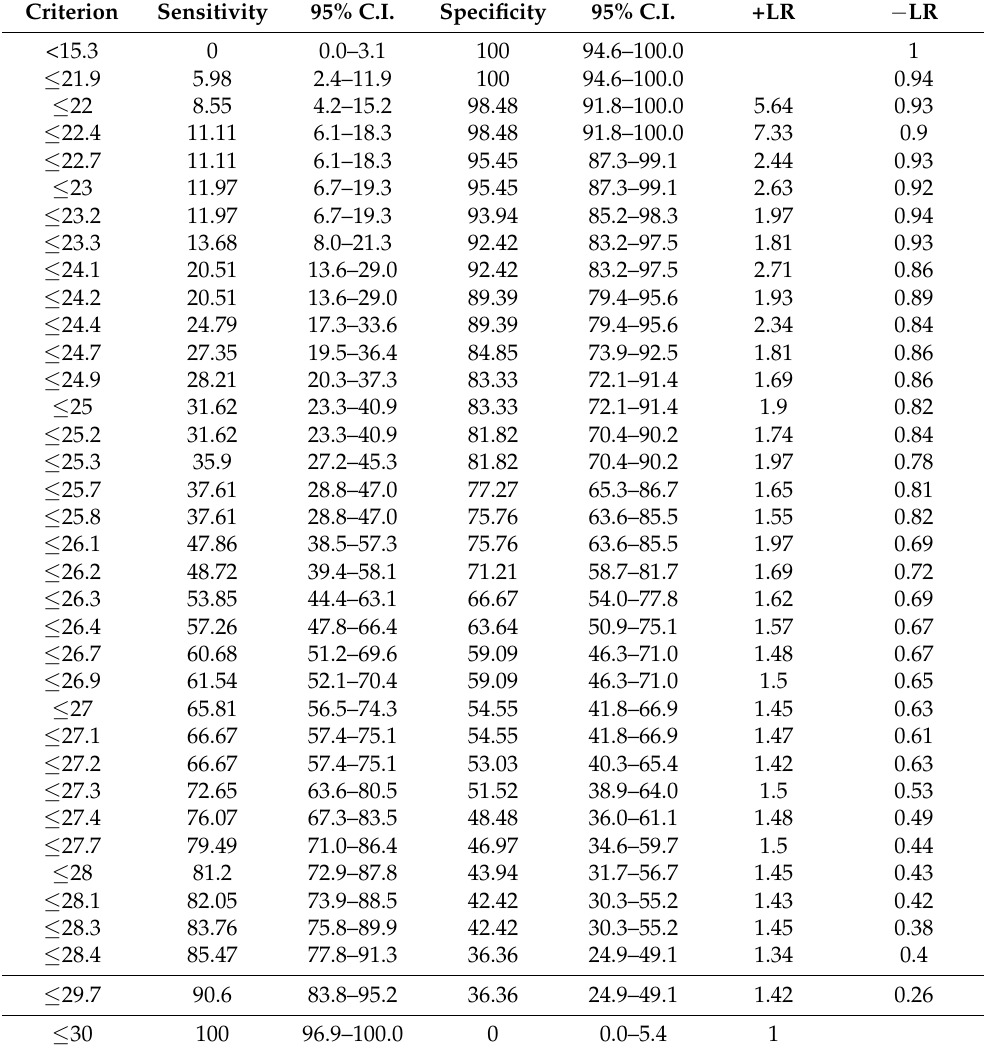
Table 4. Criterion values and coordinates of the ROC curve (mild